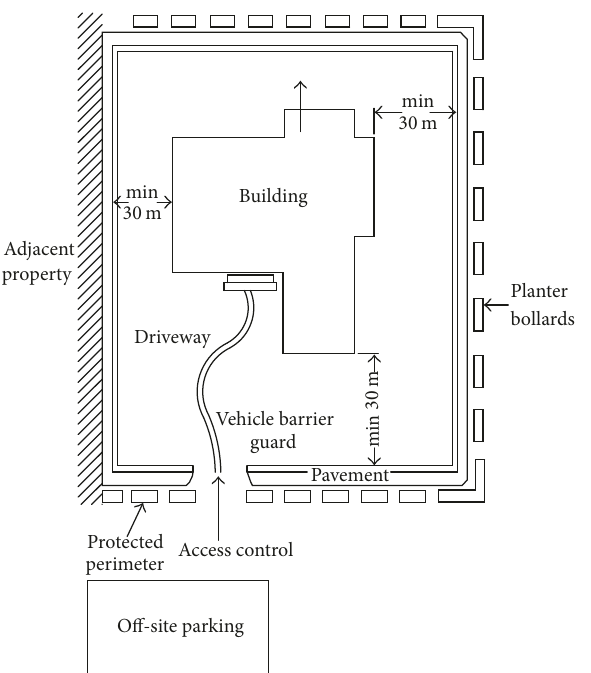
Figure 14: Layout of building for blast